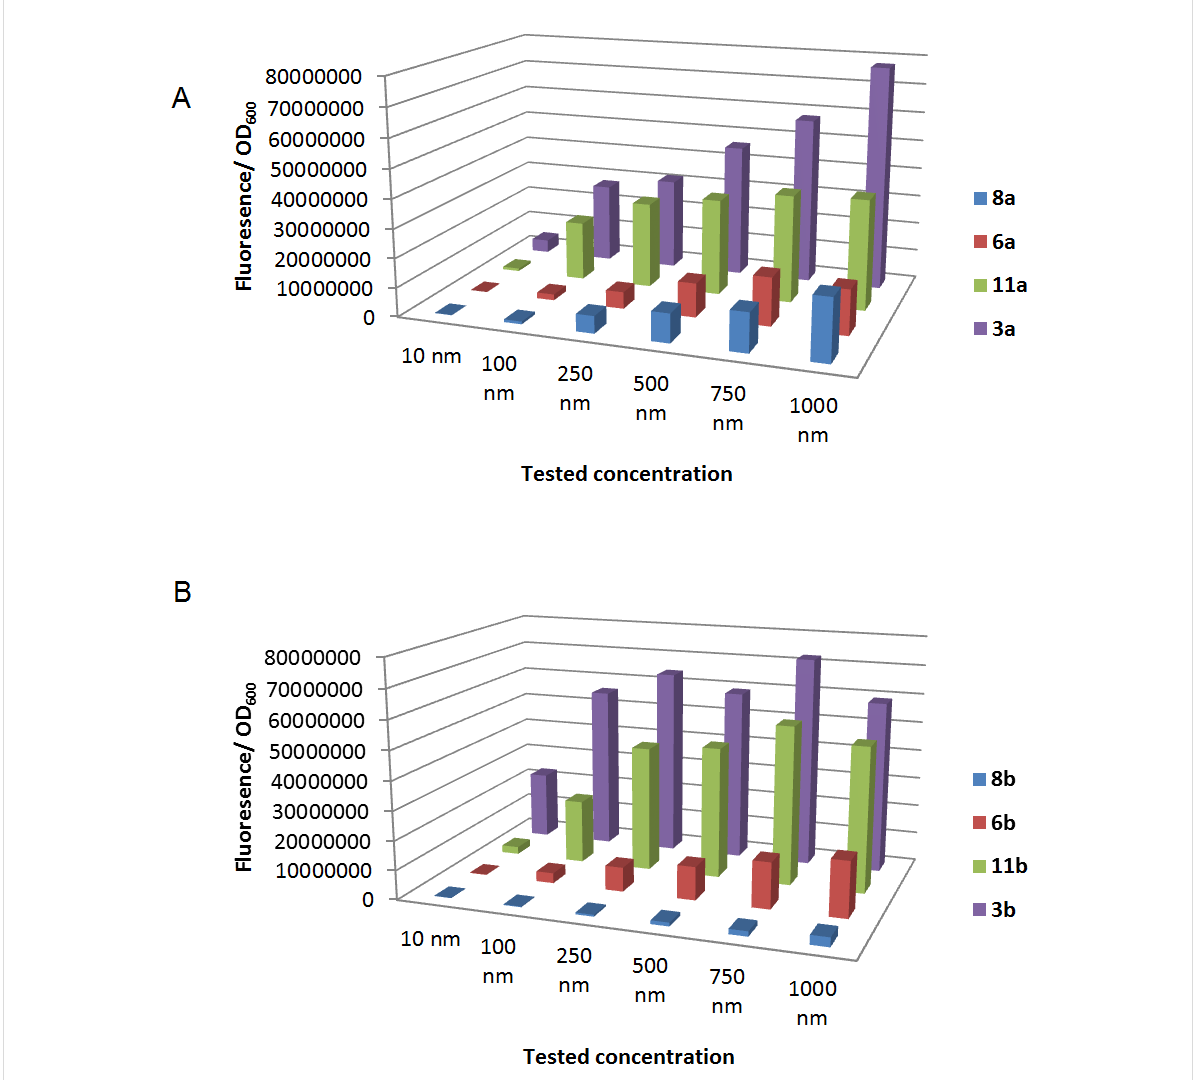
Figure 2: Normalized fluorescence values for natural AHLs 3a , b and α -haloacylated analogues 6 , 8 and 11 tested in various concentrations. A; com- parison of AHLs with chain length of 6 carbons. B; comparison of AHLs with chain length of 7 carbons. See Supporting Information File 1 for full experimental